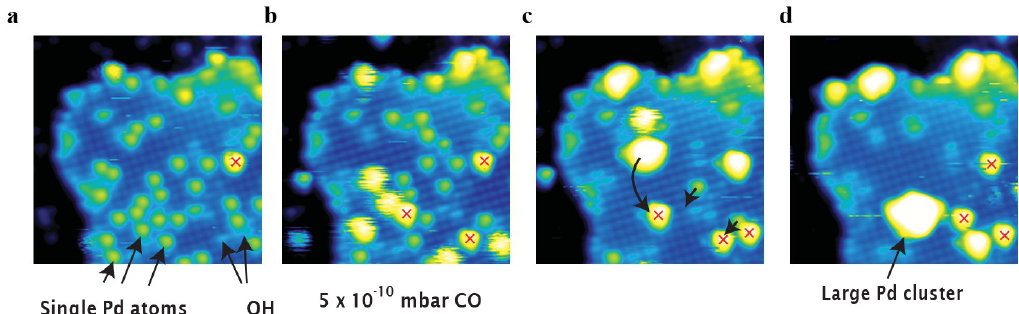
Figure 26. “The CO-induced formation of a large Pd cluster. a–d, Four STM images (14 × 14 nm 2 , +1 V, 0.2 nA) selected from a 36-frame STM movie (duration 1 h 50